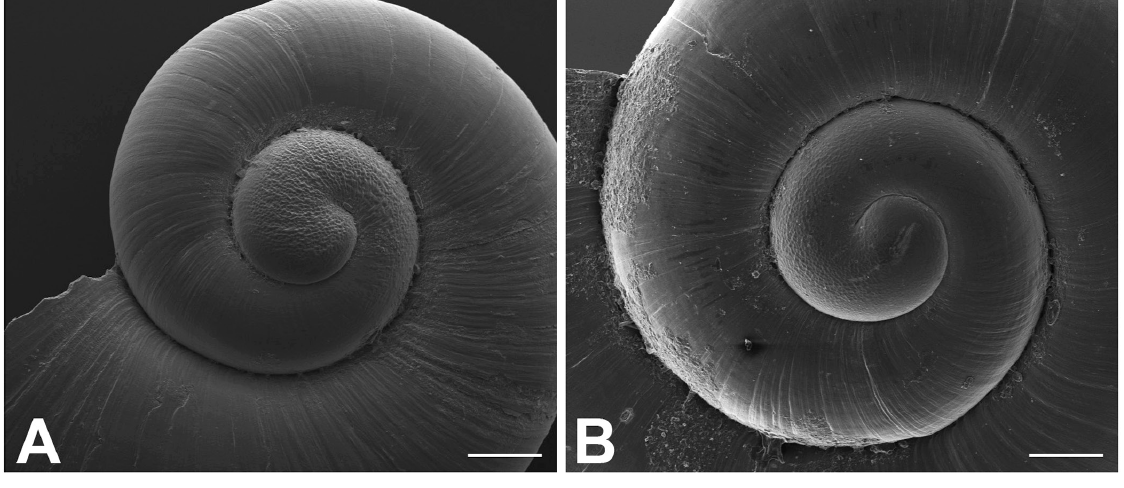
Fig. 14. Protoconchs (SEM micrographs). A . H. lozekiana sp. nov., paratype (NHMW